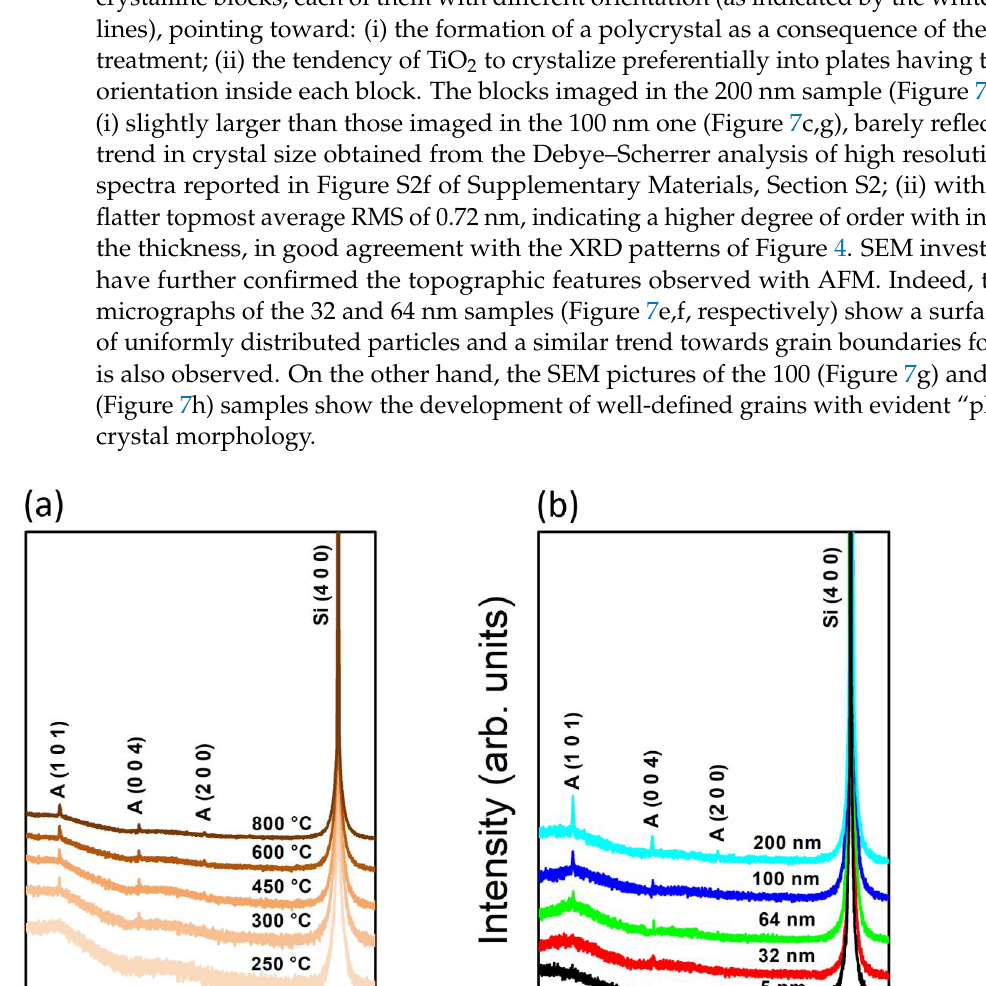
Figure 6. Tapping mode AFM topography, 10 × 10 μm in size, of: ( a ) 5, ( b ) 32, ( c ) 64, ( d ) 100, and ( e ) 200 nm samples, annealed at 800 °C. In figure ( c ), the black dotted arrows are guides for the eye highlighting grain boundaries. ( f ) 5, ( g ) 32, ( h ) 64, ( i ) 100, and ( j ) 200 nm samples, annealed at 1000 °C. The color scale of the samples annealed at 800 °C ranges from: 0 to 5 nm for 5, 64 and 100 nm; 0 to 2 nm for 32 nm; 0 to 15 nm for 200 nm. The color scale of the samples annealed at 1000 °C ranges from: 0 to 100 nm for 5 nm; 0 to 60 nm for 32, 64 and 100 nm; 0 to 80 nm for 200 nm.